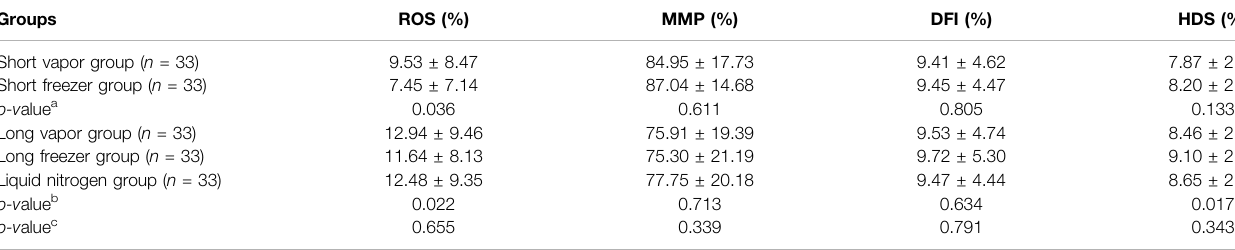
TABLE 3 | Comparison of sperm function between liquid nitrogen vapor rapid freezing and − 80 ° C freezer.